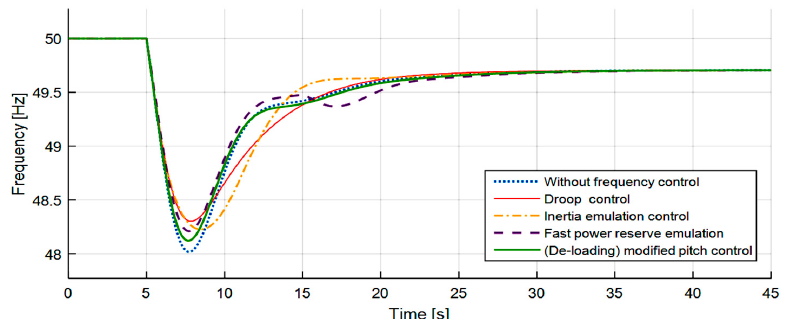
Figure 15. Frequency response for different controllers in high wind speed case after frequency disturbance.